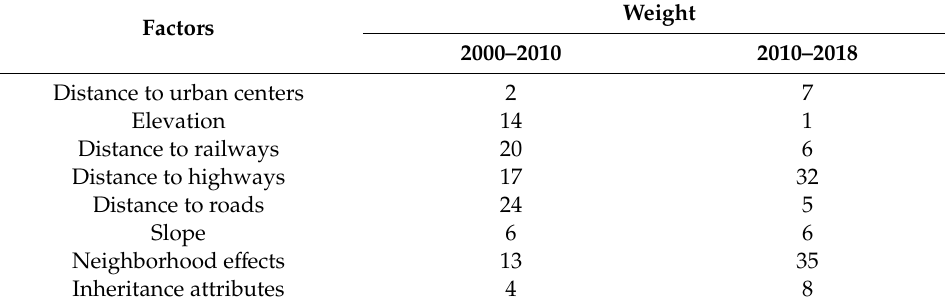
Table 2. The calibration and verification of the land use scenario dynamics (LUSD)-urban model. Factors